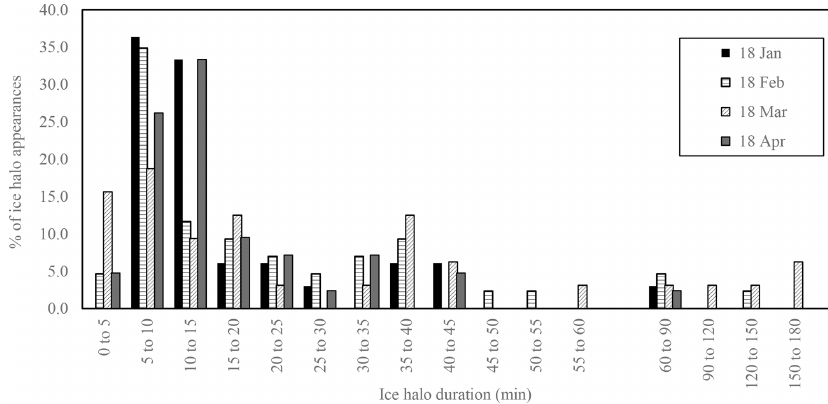
Figure 9. Distribution of observed 22 ◦ halo durations for the first 4 months of 2018 at the SGP ARM